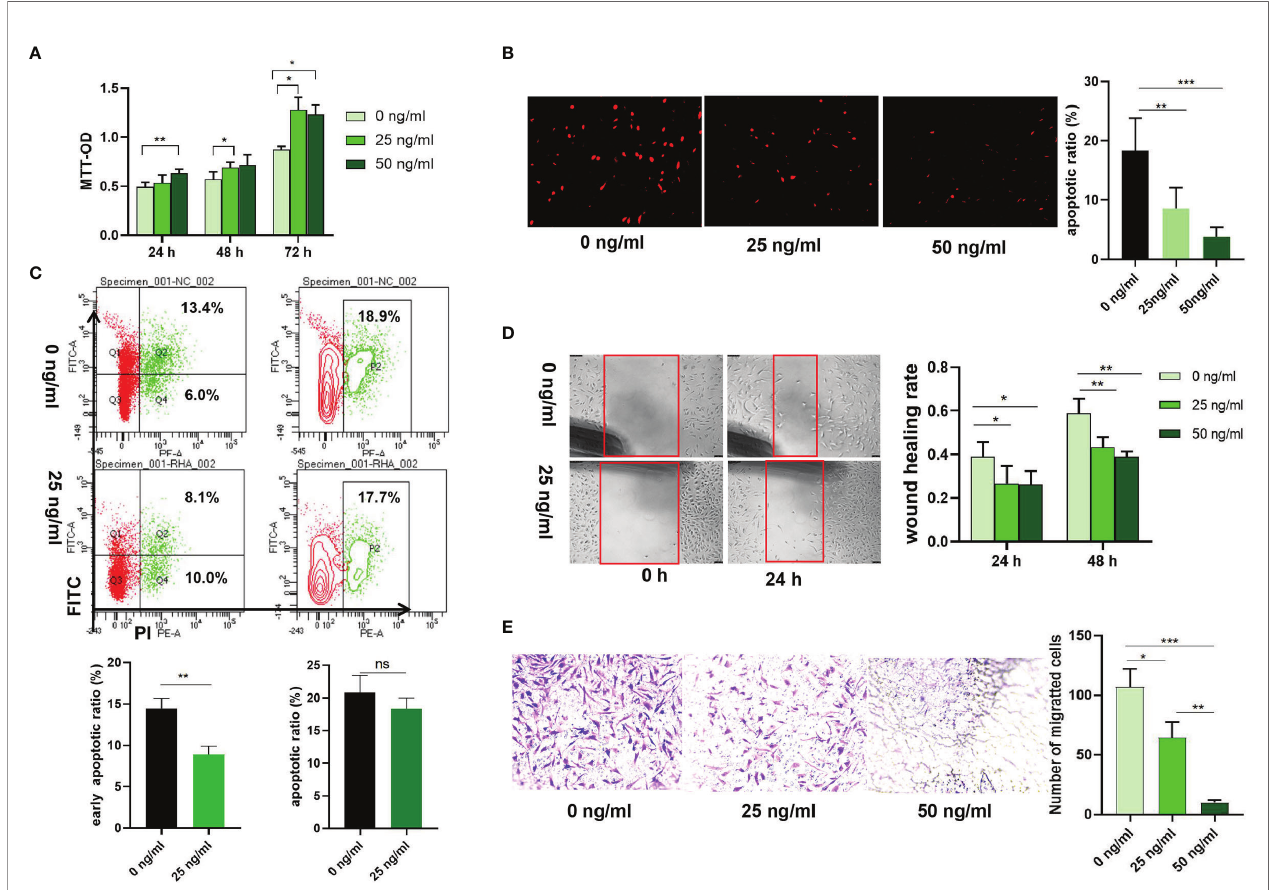
FIGURE 4 | Effects of rHAPLN1 on RA-FLSs activity. (A) Treatment of RA-FLSs with rHAPLN1 signi fi cantly enhanced the (A) proliferation but reduced (B, C) apoptosis of RA-FLSs (magni fi cation: 10×10), especially during the early phase and (D, E) migration. Wound healing (D) and transwell (E) assays were used to evaluate the migration capacity of FLSs (magni fi cation:10×5). ns, not signi fi cant; *p < 0.05; * *p < 0.01; ** *p <